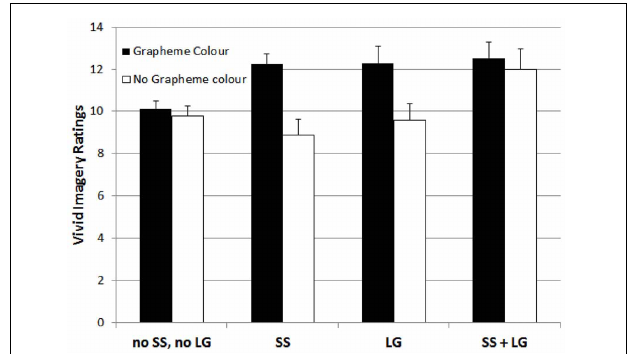
FIGURE 3 | Mean ratings for participants with neither sequence-space nor lexical gustatory synaesthesia (no SS, no LG), sequence-space synaesthesia (SS), lexical gustatory synaesthesia (LG), and with both sequence-space and lexical gustatory synaesthesia (SS + LG), separated by whether or not grapheme-color synaesthesia was also present, on the vivid imagery style dimension. Error bars represent standard errors.